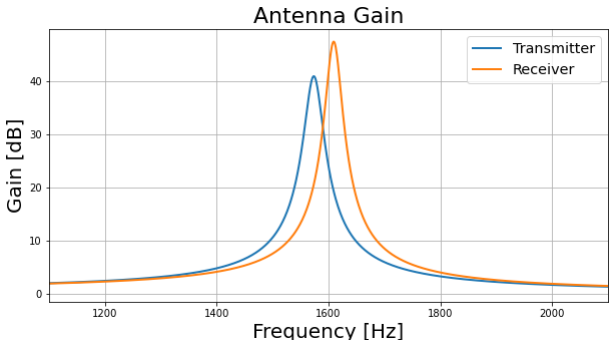
Figure 5. Response of the RLC circuit present in the transmit- ter unit, with inductance L coil = 13 . 28mH, capacitance C coil = 770nF, and resistance R coil = 3 . 2 (cid:127) , and across the receiver unit, with inductance L coil = 12 . 7mH, capacitance C coil = 770nF, and resistance R coil = 2 . 7 (cid:127) . The filtered signal can be measured over any of the components; however, both antennas measure the signal across the capacitor component. This is due to the small gain across the resistor component, and that the inductor in the RLC circuit is the antenna